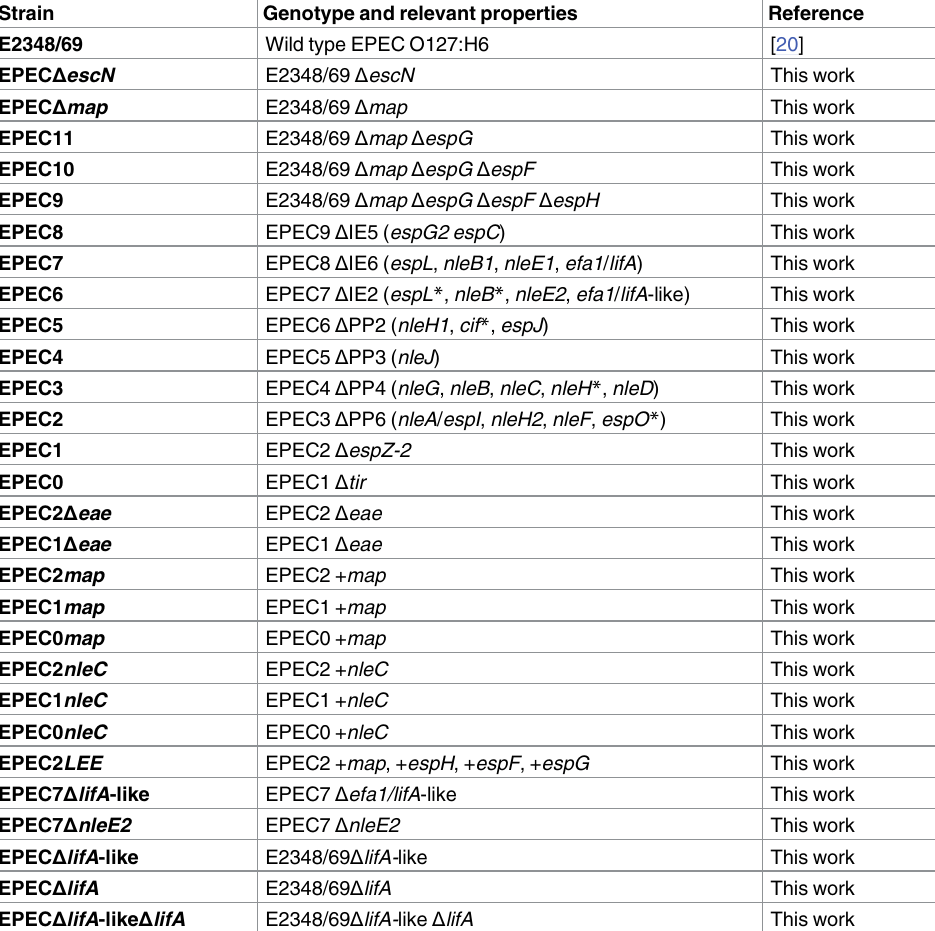
Table 1. EPEC strains used in this